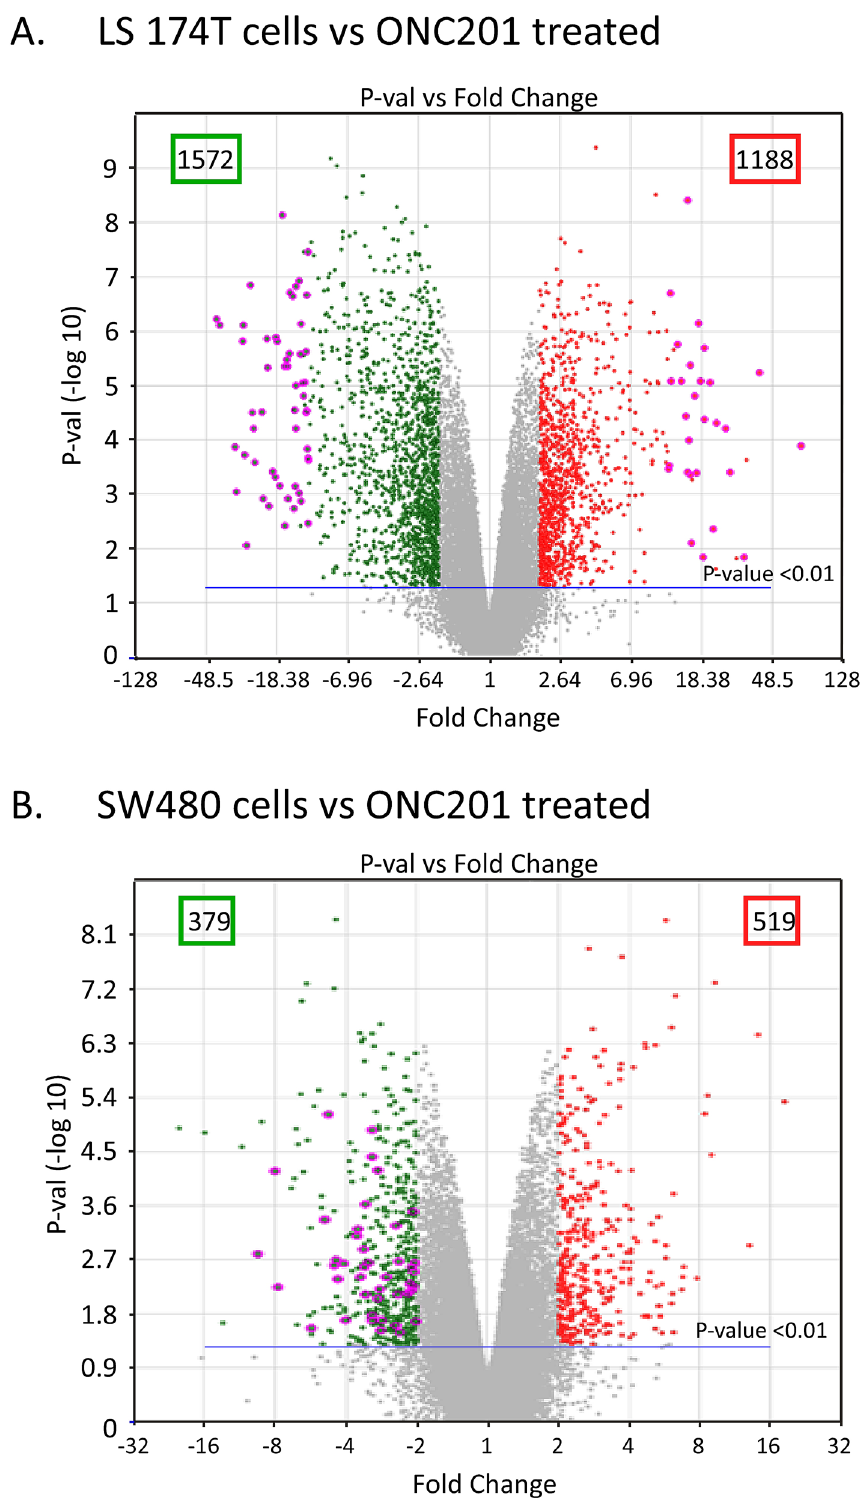
Figure 2. Affymetrix microarray analysis of LS-174T and SW480 cells treated with or without ONC201. Volcano graphs illustrating the differential gene expression in LS174T ( A ) and SW480 ( B ) cells in response to ONC201 treatment. Each dot represents one gene that had detectable expression in either cell line in response to ONC201 treatment. The horizontal line marks the threshold ( P < 0.01). The color code defines an upregulated gene as red and a downregulated gene as green, with the change ≥ twofold relative to control (vehicle-treated cells). The software Affymetrix Expression Console (Version 1.0) was used for the analysis as described by the manufacturer (Material and